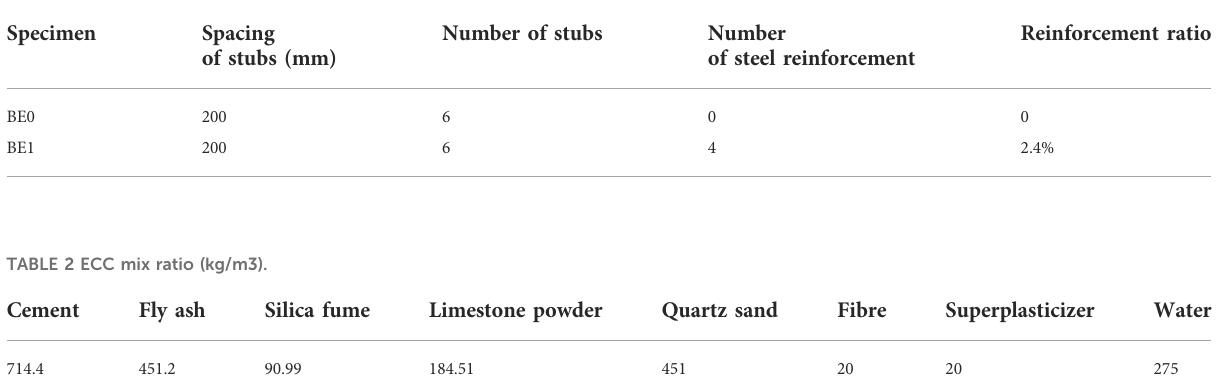
TABLE 1 Parameters of steel-ECC composite deck.